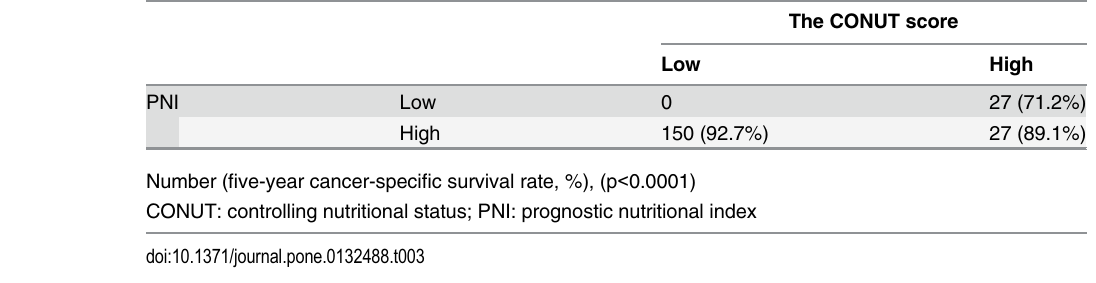
The correlations between the CONUT/PNI and the clinicopathological factors The CONUT score had a significant relationship with the age (p = 0.0016) and tumor location (p = 0.0168). The PNI had significant relationship with the age (p = 0.0001), tumor location (p = 0.0224), and adjuvant chemotherapy (p = 0.0030) (Table 2). Table 3. The distribution according to the CONUT score/PNI and the five-year survival rate.